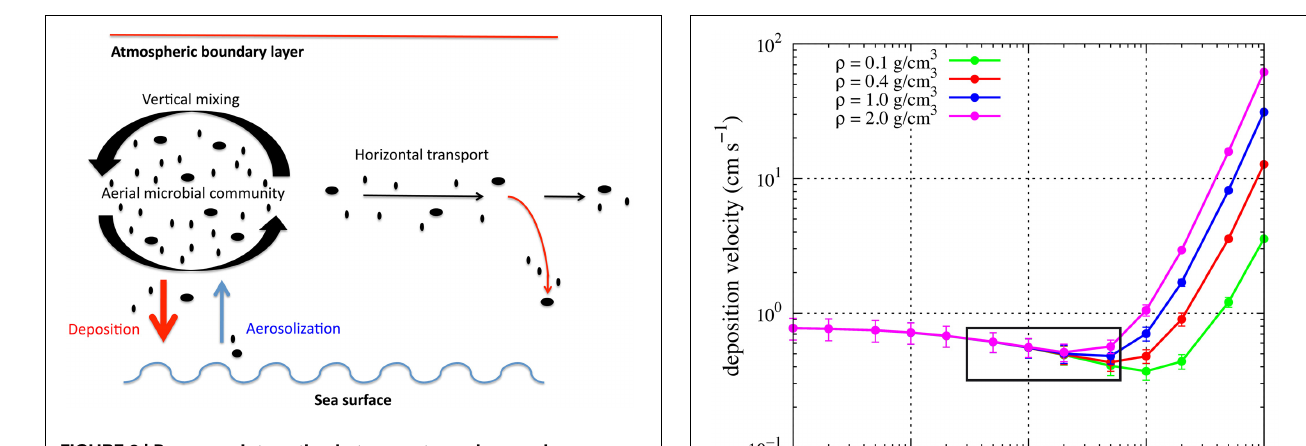
FIGURE 2 | Processes interacting between atmosphere and ocean taken into account in this work. Vertical mixing is assumed as a process that generates a homogeneous boundary layer. Aerosolization, deposition and transport are estimated values assuming a homogeneous boundary layer. FIGURE 3 | Dependence of deposition velocities on particle density